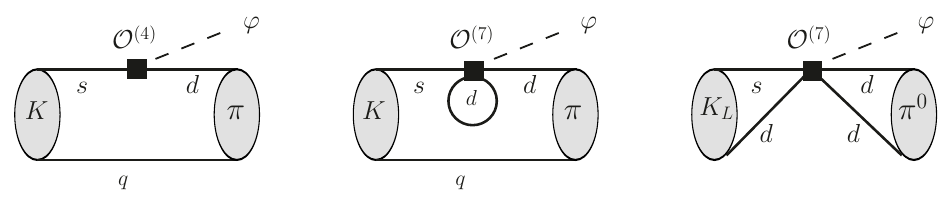
Figure 2 . Contributions from dimension 4 ((cid:12)rst diagram) and dimension 7 (2nd and 3rd diagrams) (cid:25)’ transition. The last diagram contributes to K L EFT operators to the K ! The quark-loop diagram in the middle corresponds to the S; E classes of diagrams and the weak annihilation diagram on the right to the W; C classes of diagrams in the lattice computation of ref.